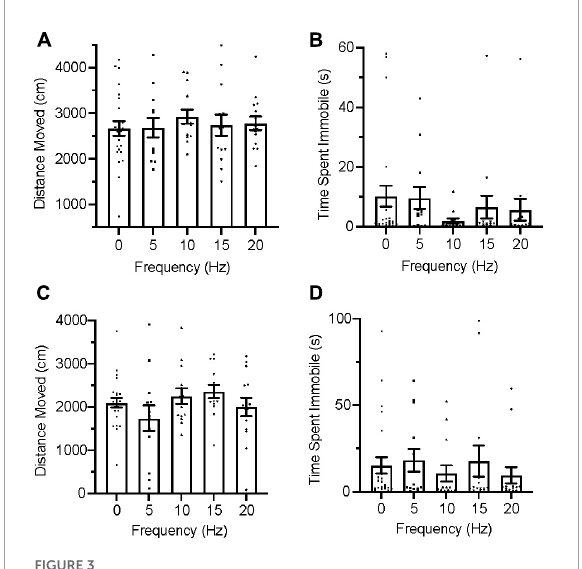
FIGURE3 Zebrafish locomotion during acclimation and infrasound exposure. (A) Average distance moved during the acclimation period. (B) Average time spent immobile during the acclimation period. (C) Average distance moved during infrasound exposure. (D) Average time spent immobile during the infrasound exposure period. Data points represent individual zebrafish. Error bars represent